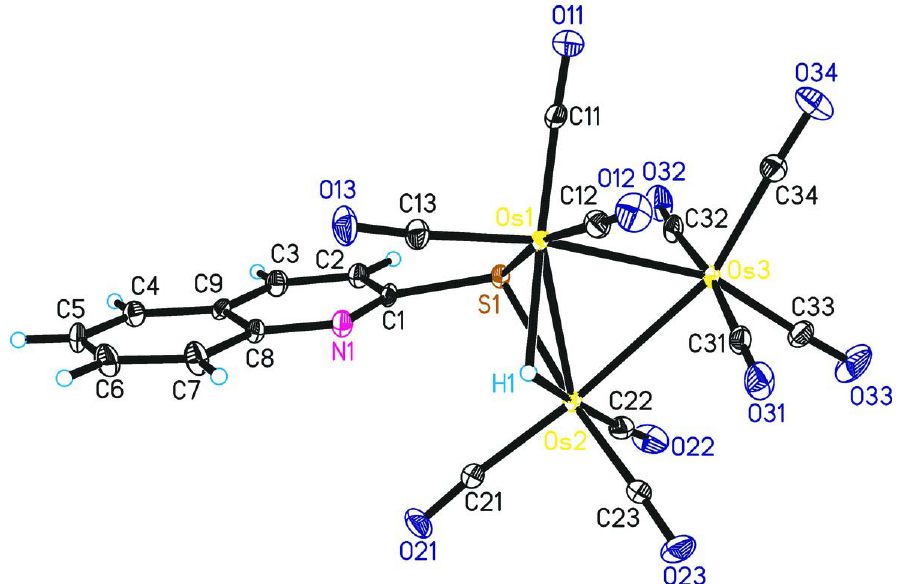
The molecular structure of the title compound. Displacement ellipsoids are drawn at the 30% probability